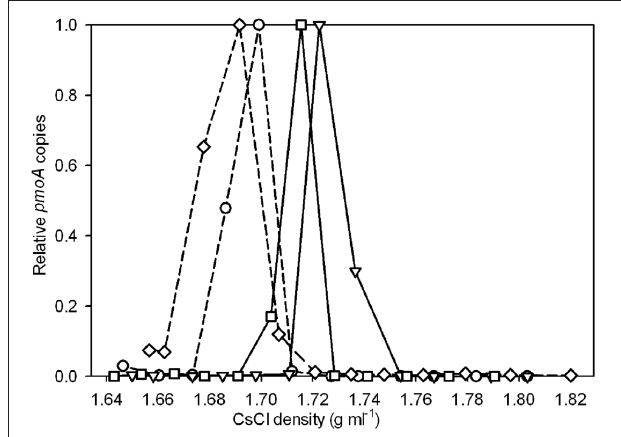
FIGURE 1 | Relative pmoA gene abundances recovered from CsCl gradient fractions for strain V4 after incubation with 13 CH 4 + 12 CO 2 ( (cid:3) ), 13 CH 4 + 13 CO 2 ( ∇ ), 12 CH 4 + 13 CO 2 ( (cid:2) ), and a 12 CH 4 + 12 CO 2 control ( (cid:3) ). Solid lines represent incubations with 13 CO 2 and dashed lines represent incubations with 12 CO 2 . The y-axis indicates the relative abundance of pmoA genes recovered from each gradient fraction, with the highest quantity detected in any gradient fraction set to 1.0. Relative abundances rather than absolute pmoA gene counts are used to facilitate comparison across the different experiments. Points are averages of duplicate qPCR measurements. Experiments were performed in duplicate, one representative experiment is shown as duplicate experiments showed similar